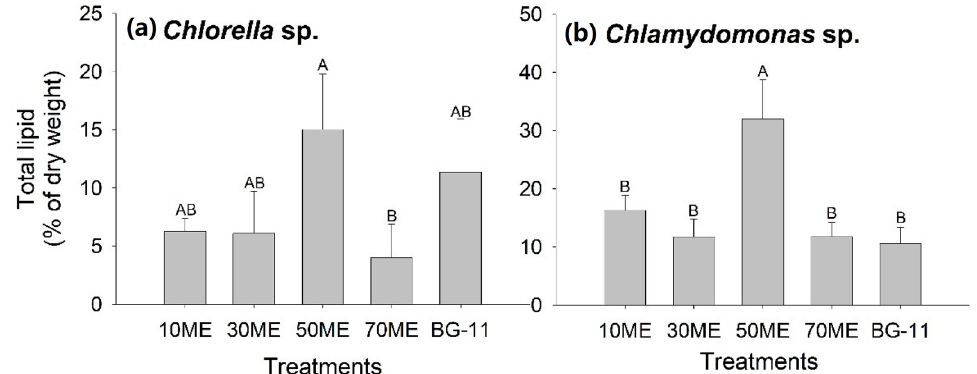
Figure 10. Variation of total lipid ( a ) Chlorella sp. and ( b ) Chlamydomonas sp. cultivated using the diluted malting effluent and standard mineral media (BG ‐ 11) during 22 days of cultivation time. The bars represent mean lipid content and errors refer to standard deviation. The statistics were derived from a one ‐ way ANOVA with post hoc Tukey test. The different letters above the bar signify the significant difference at p < 0.05.